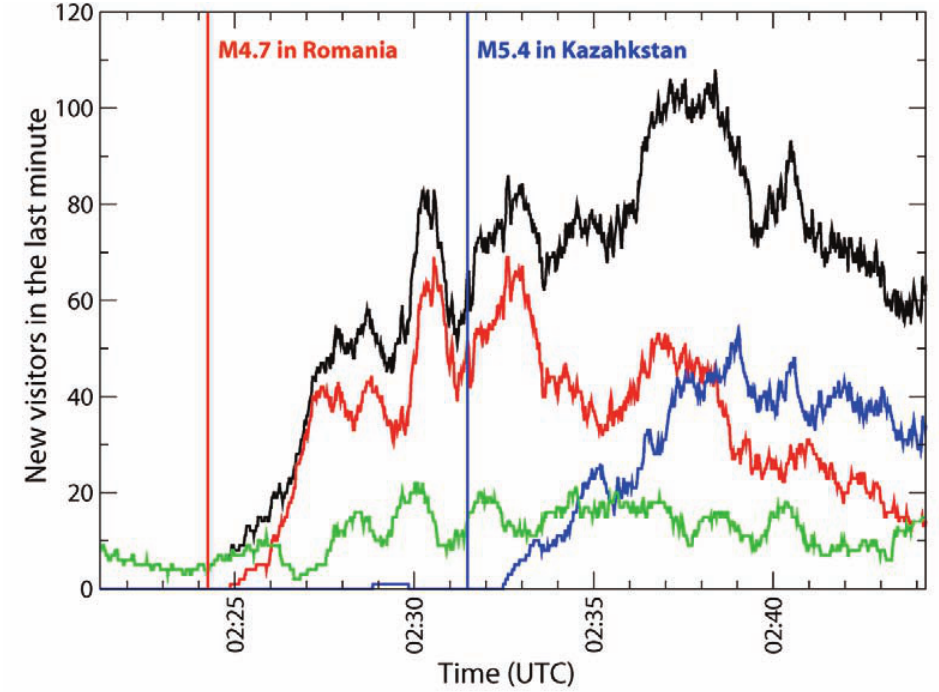
Figure 11. Superposition of website traffic surges caused by two distant felt earthquakes. On May 1, 2011, a M 4.7 earthquake in Romania was followed 7 min later by a M 5.4 earthquake in eastern Kazakhstan. The observed website traffic (black line) is the addition of the website traffic originating from Romania, Bulgaria and Moldova, the three countries where the first shock was felt, according to the EMSC macroseismic map (red line), and the one originating from Kazakhstan, and the baseline website traffic (green line). This demonstrates that the traffic can be broken down in its distinct components by geographic